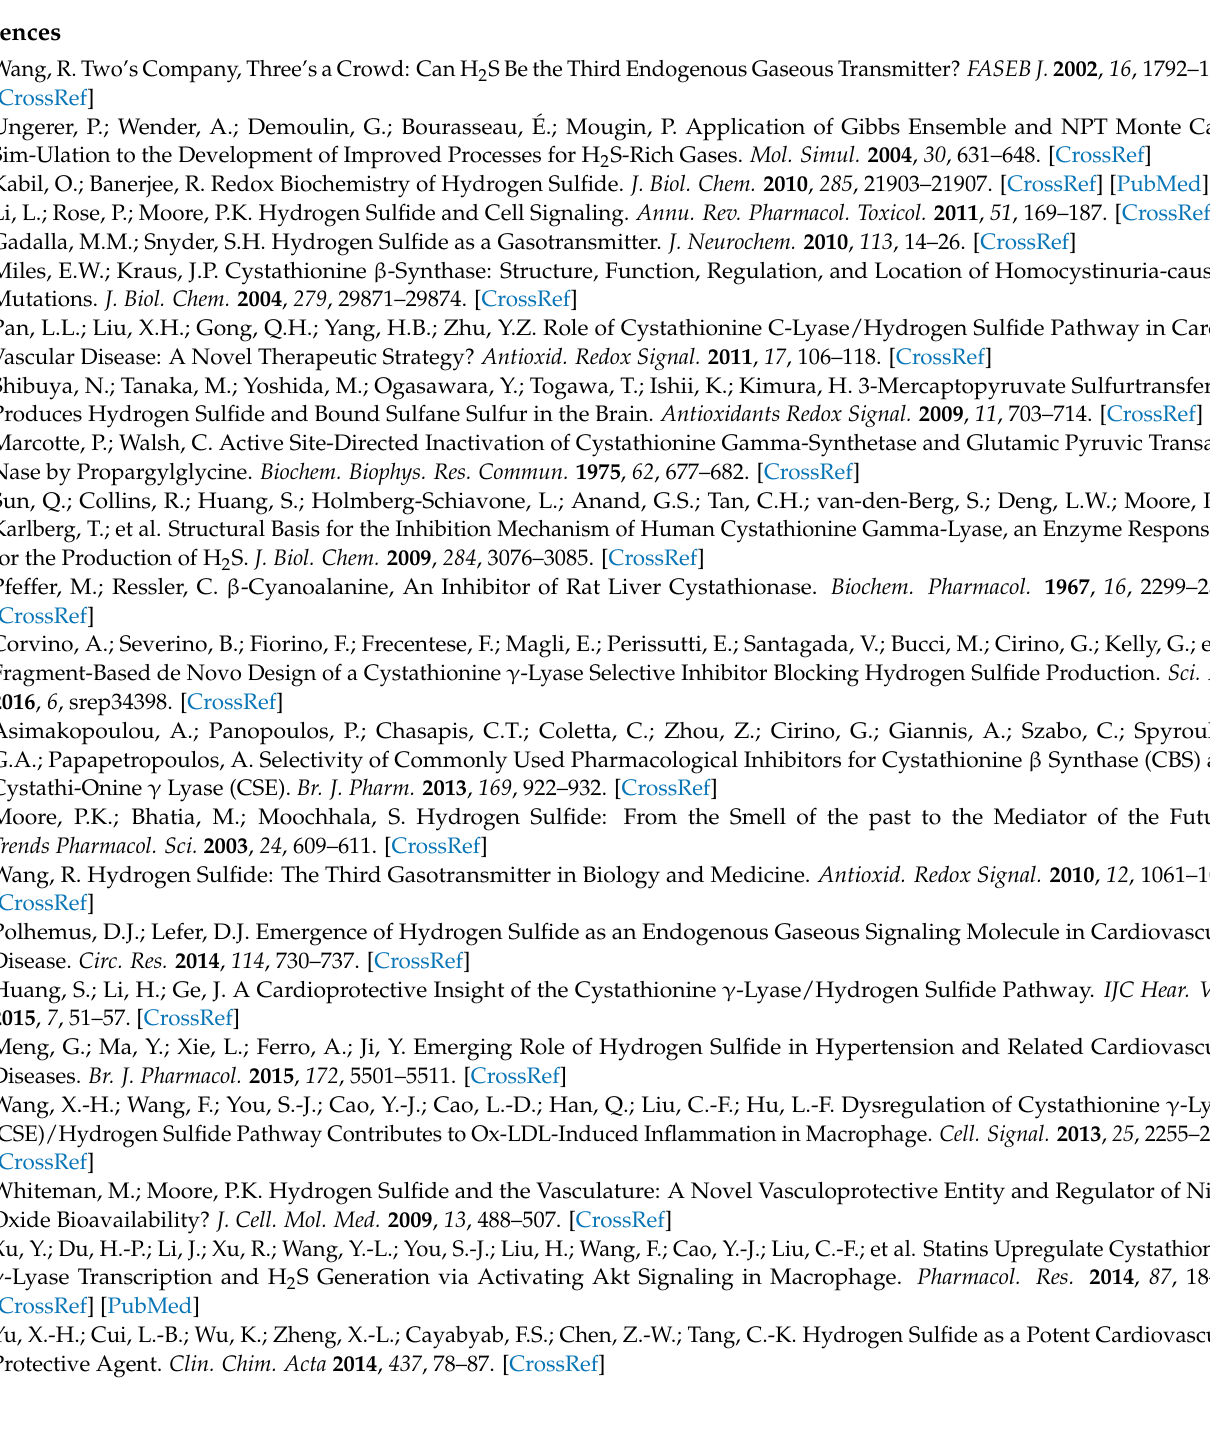
Figure S28. Synthesis of thioamino acids. Figure S29. Chemical structure and synthesis of ZYZ803. Figure S30. Chemical structures of ( a ) zofenopril and ( b ) its active metabolite,